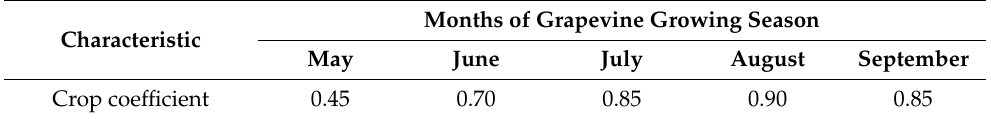
Table 1. Values of crop coefficients for grapevines